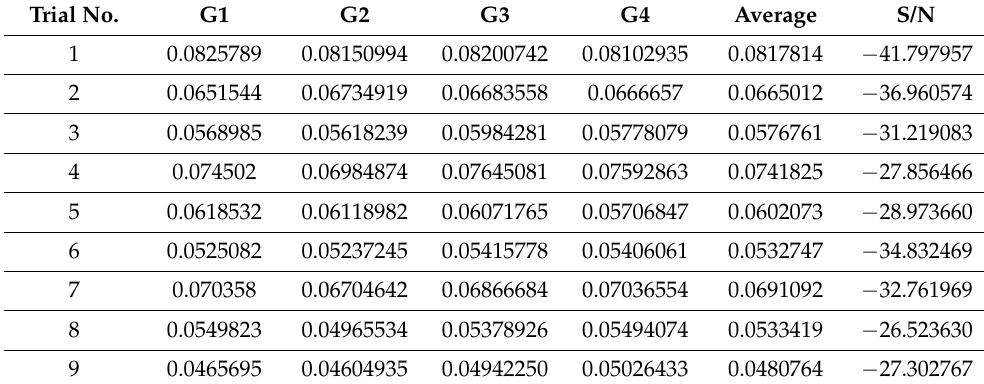
Table 6. Responses measured during the implementation of the crossed OA. Trial No.